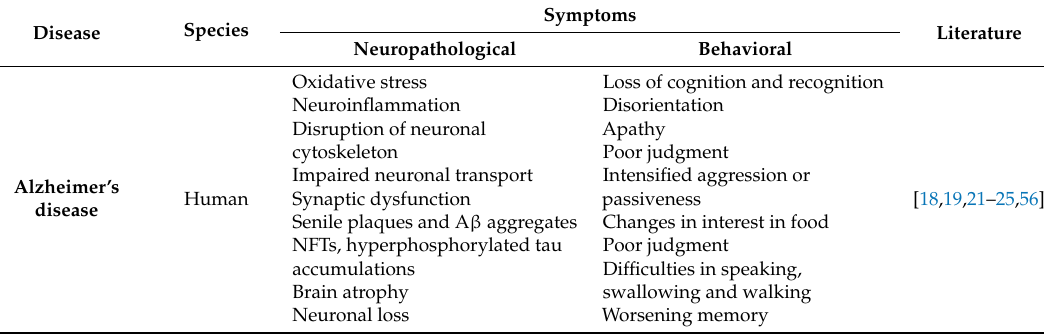
Table 1. Summary and comparison of Alzheimer’s and Alzheimer’s-like diseases symptoms.